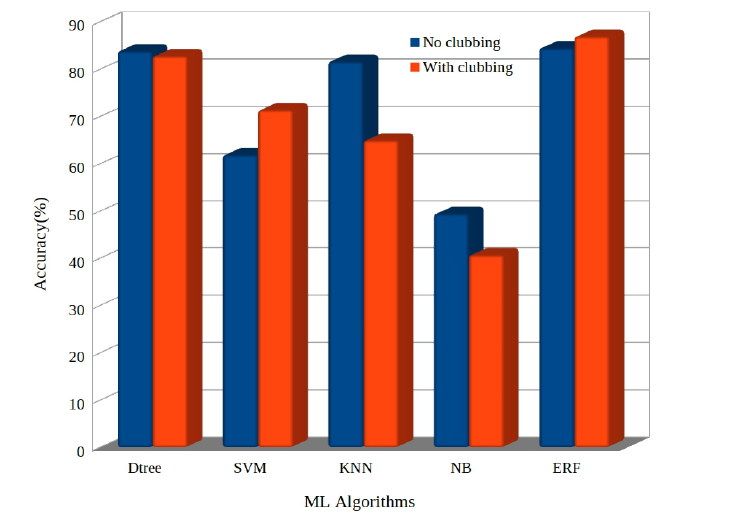
Figure 13. Overall accuracy performance.